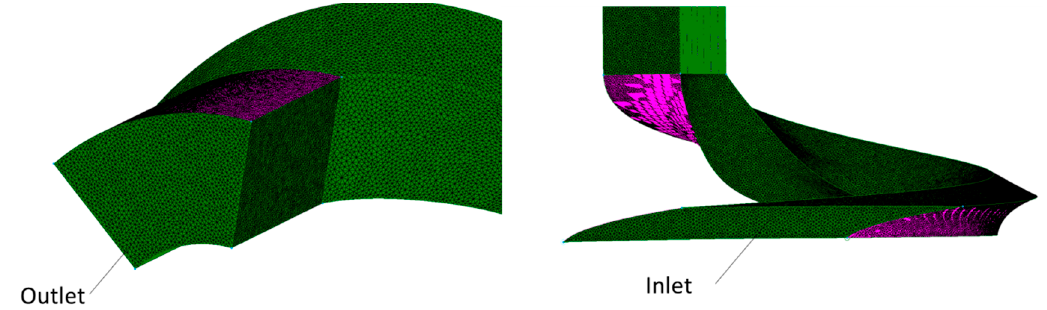
Figure 5. Grid details of the single vane geometry with 7 blades where the outlet and inlet section of the pump under turbine operating conditions are specified.